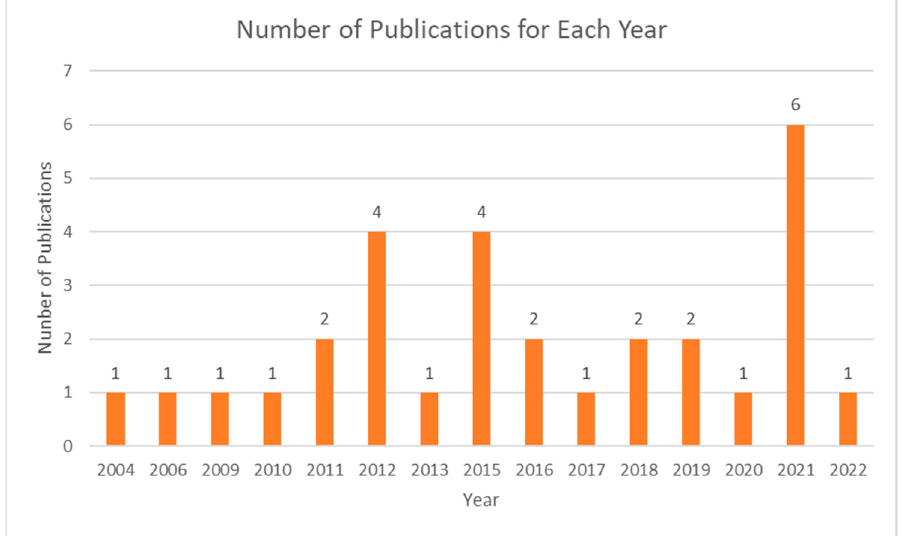
Figure 6. Number of publications on stakeholder engagement framework for IRBM from the years 2000–2022.